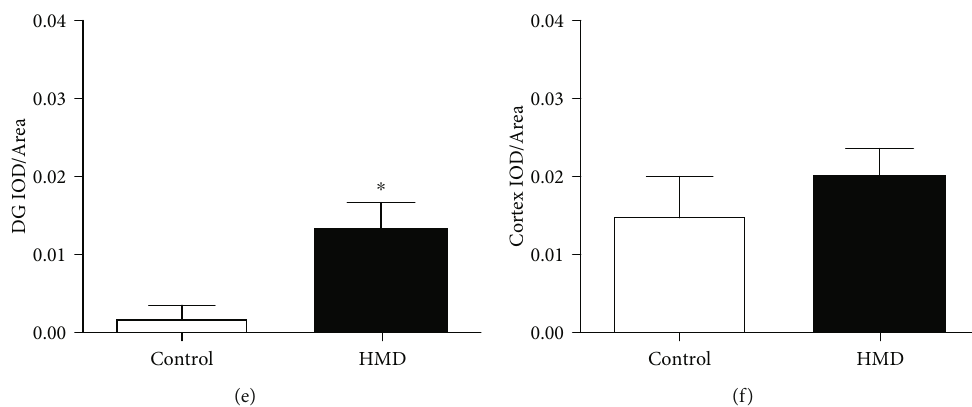
Figure 5: E ff ect of HMD on A β IF staining of hippocampal and cortex tissue in mice. Sections of the hippocampus CA1, CA3, DG region, 1-42 and cortex were obtained and stained with IF (magni fi cation, 400 × ). (a) Showed representative photomicrographs of A β of each group in hippocampal CA1 region. (b) Showed representative photomicrographs of A β hippocampal CA3 region. (c) Showed the CA1 IOD/area of each group. (d) Showed the CA3 IOD/area of each group. (e) Showed the DG IOD/area of each group. (f) Showed the cortex IOD/area of each group. Note: value was expressed as mean ± SEM ( n = 4 ). ∗ p < 0 : 05 vs. control